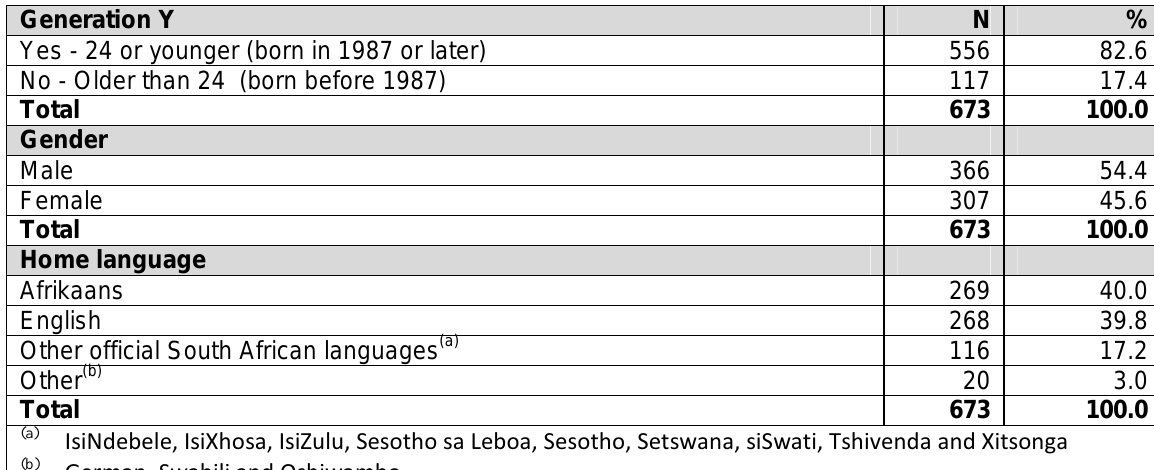
Table 2: Sample description – demographic details Generation